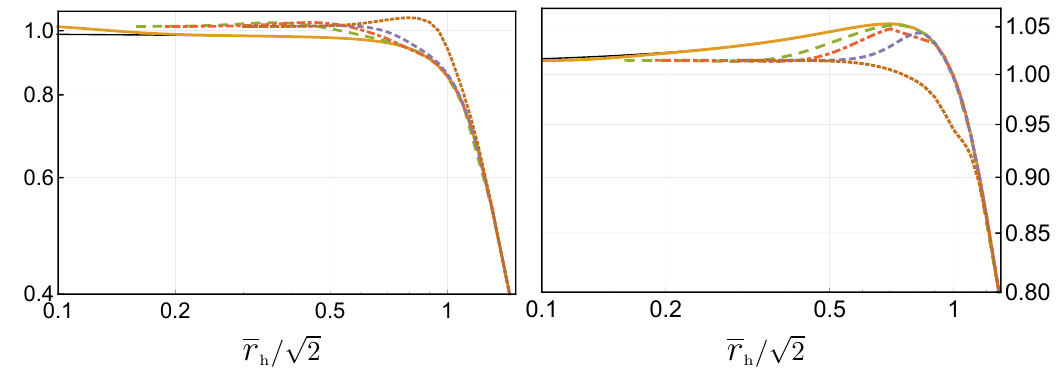
p 2 N (see legend in (cid:12)gure q